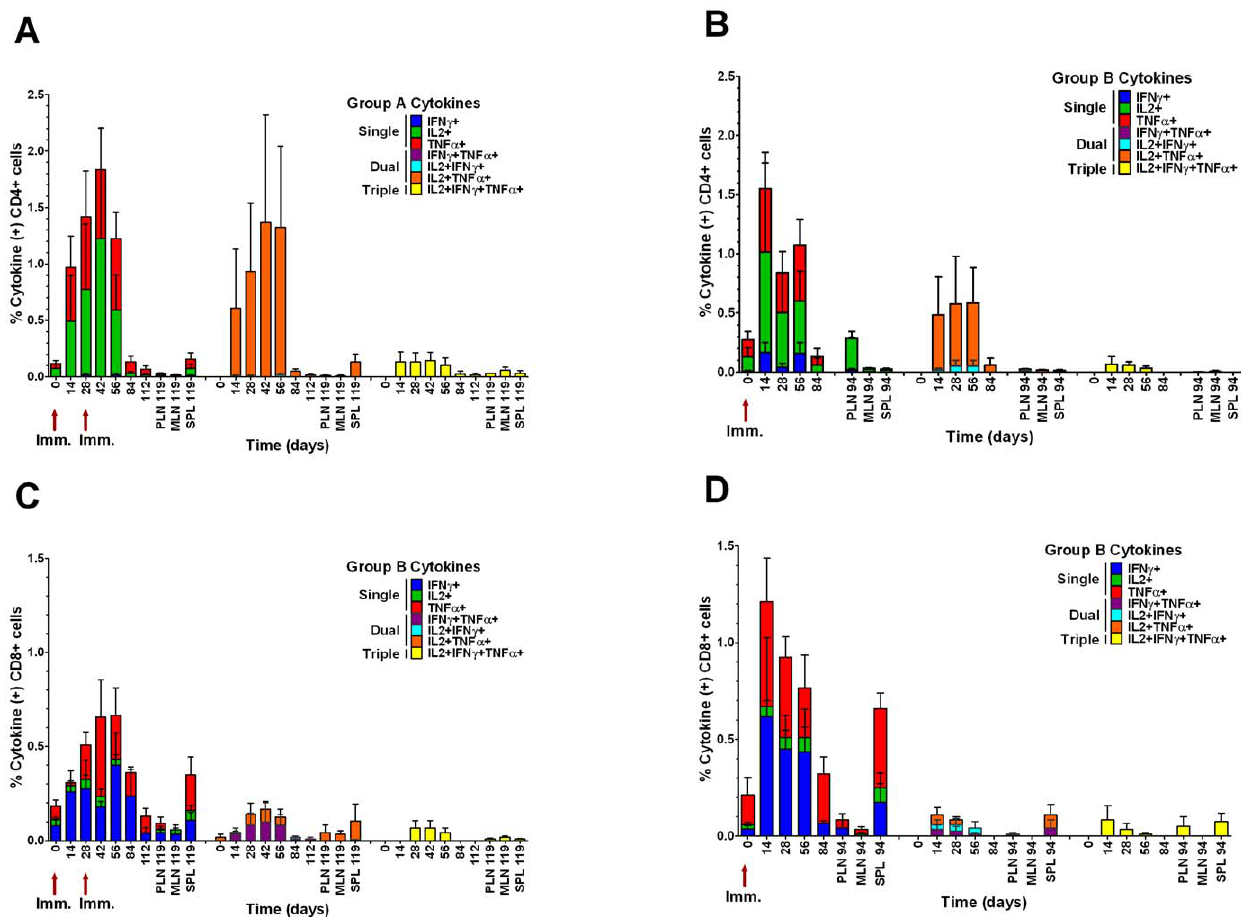
Figure 4. Repertoire of macaque cytokine responses to HIV-1 F4 peptides. Single, double and triple cytokine (TNF a + , IL-2 + and IFN c + cells) responses by CD4 + (A and B) and CD8 + T cells (C and D) from peripheral blood (PBMCs), peripheral lymph nodes (PLN), mesenteric lymph nodes (MLN) and spleen (SPL). Group A, macaques F51–F54, were immunised with 10 5 TCID 50 MV1-F4 on days 0 and 28 whilst group B, macaques F55–F58, were immunised on day 0 only. Columns represent group mean values 6 SEM, n=4. Single cytokine positive cells represented by IFN c + (blue), IL-2 + (green), TNF a + (red), dual cytokine positive cells represented by IFN c + TNF a + (purple), IL-2 + IFN c + (cyan), IL-2 + TNF a + (orange), and triple cytokine positive cells represented by IL-2 + IFN c + TNF a + (yellow) are plotted separately.